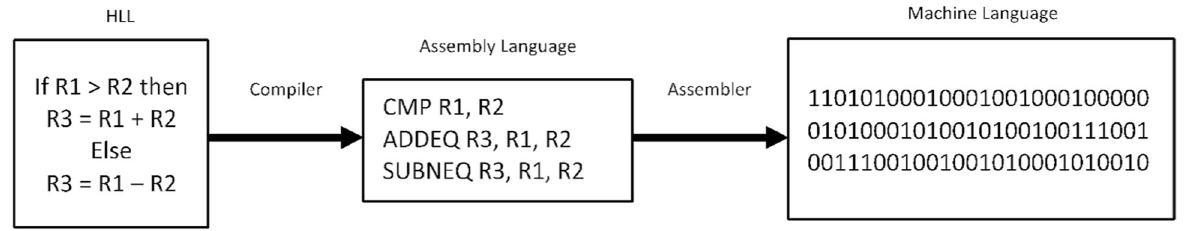
Fig. 2 The software translation process. The diagram represents the transition from a HL program to its restructuring in terms of a compiler language and then of machine